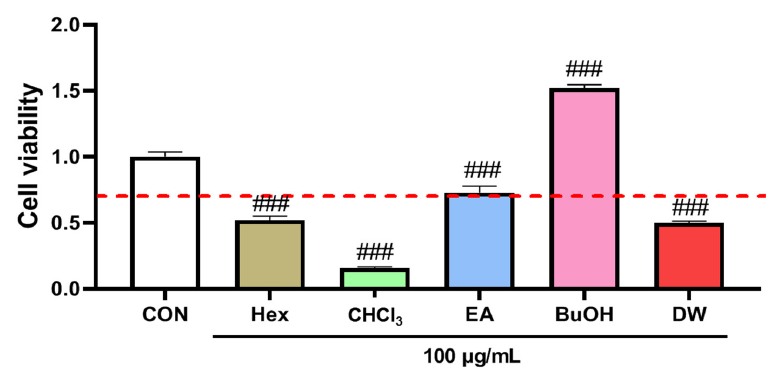
Figure 7. The effect of different fractions (at 100 µg/mL) obtained from methanol extract of liverwort on the cell viability of HaCaT Cells. CON, control; Hex, hexane fraction; CHCl 3 , chloroform fraction; EA, ethyl acetate fraction; BuOH, butanol fraction; DW, water fraction. Values are mean of three replicate determinations ( n = 3) ± standard deviation. ### p < 0.001 vs. 1% MeOH alone.